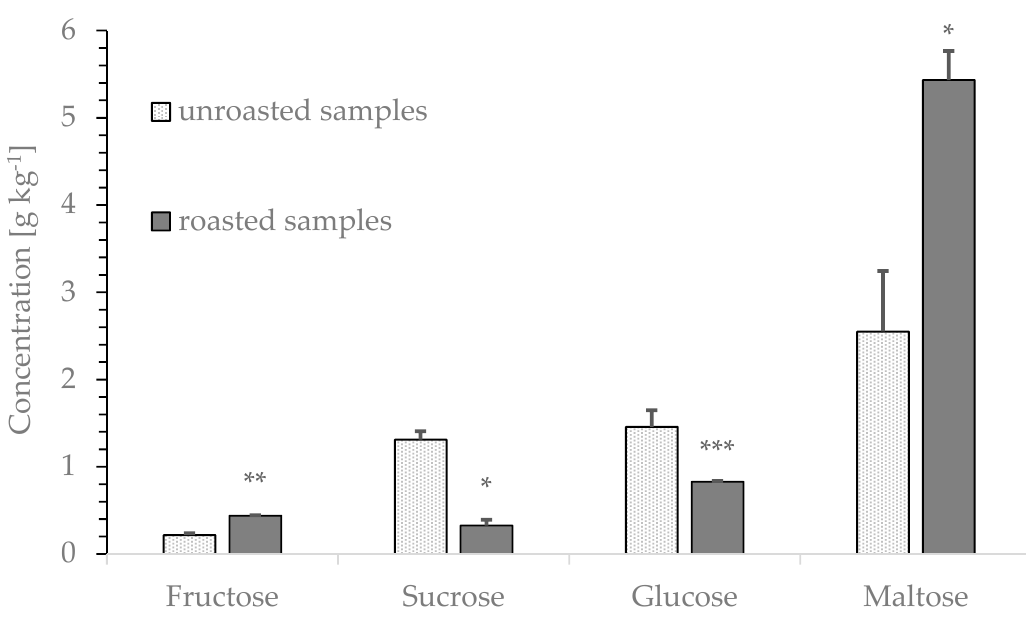
Figure 8. Carbohydrate content of rye flour and roasted rye analyzed by HPLC-CAD. Rye variety 4 milled to flour; rye variety 4 roasted at 170 °C for 20 min. n = 5 for all samples; *** p < 0.001, ** p < 0.01 and * p < 0.05 indicate significant differences from the unroasted samples.